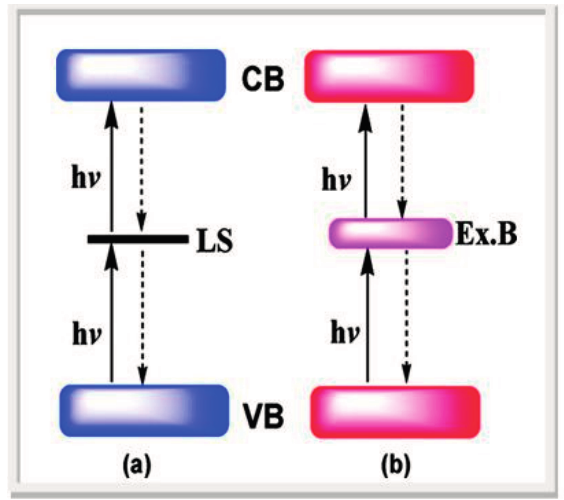
Figure 4. Successive two-photon excitation ( a ) via localized dopant states (LS) ( b ) via delocalized states in an extrinsic band (Ex.B) (reproduced from [74] with permission of